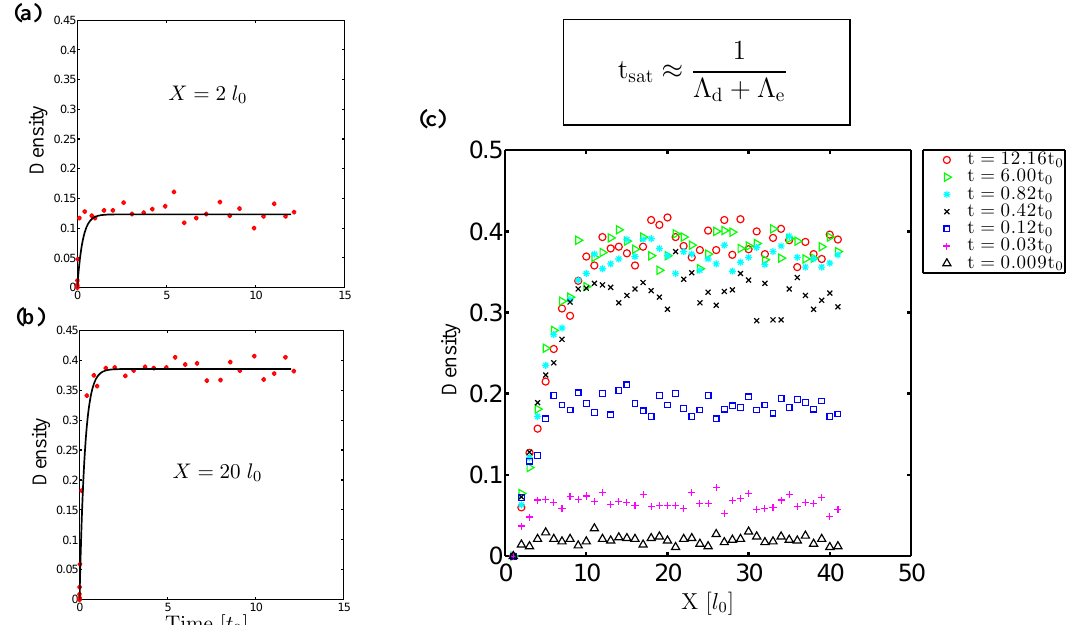
Fig. 7. Relation between the saturation time t sat and the rate parameters of the cellular automaton model. (a, b) Evolution with respect to time of the density of mobile sedimentary cells in vertical plane perpendicular to the flow at 2 l 0 and 20 l 0 from the transition from a non-erodible to an erodible bed. Despite different stationary values, note a similar relaxation time at these two positions. (c) Density of mobile sedimentary cells in vertical plane perpendicular to the flow with respect to the distance from the transition from a non-erodible to an erodible